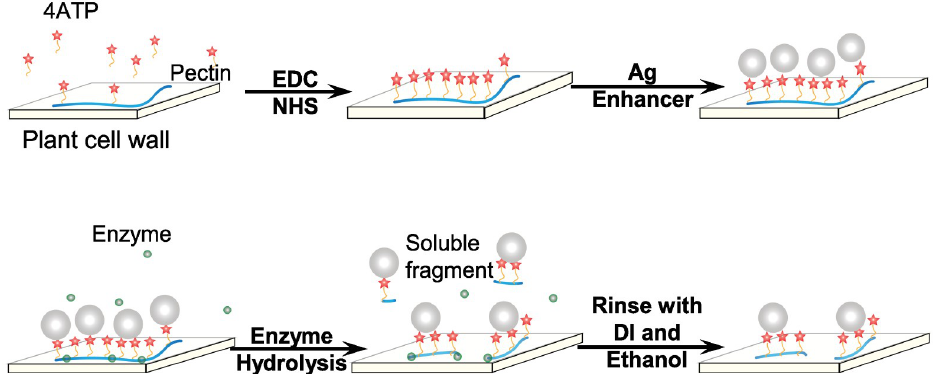
Fig 1. Experiment scheme. Layer-by-layer assemble of AgNP-4ATP-OEC and enzyme Hydrolysis of AgNP-